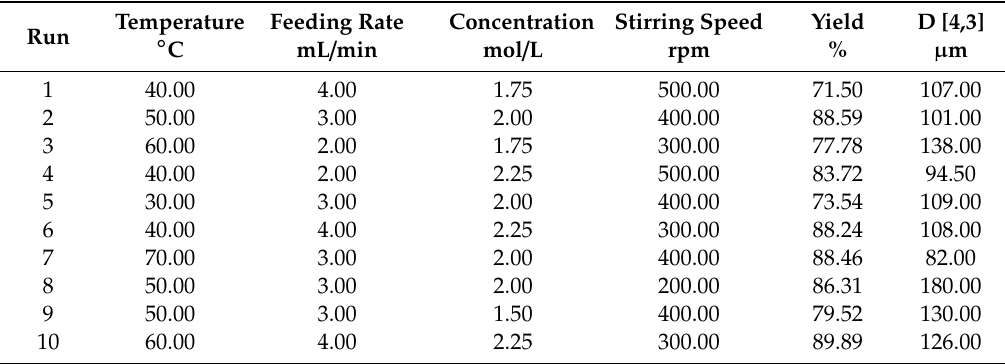
Table 6. Central composite design and experimental